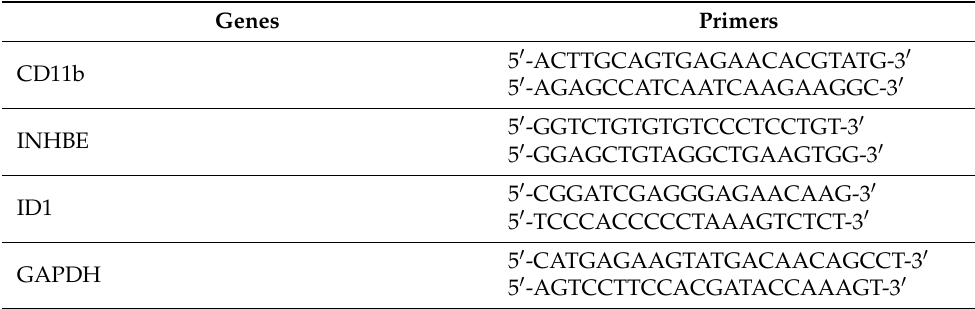
Table 2. The primer pairs used in real-time